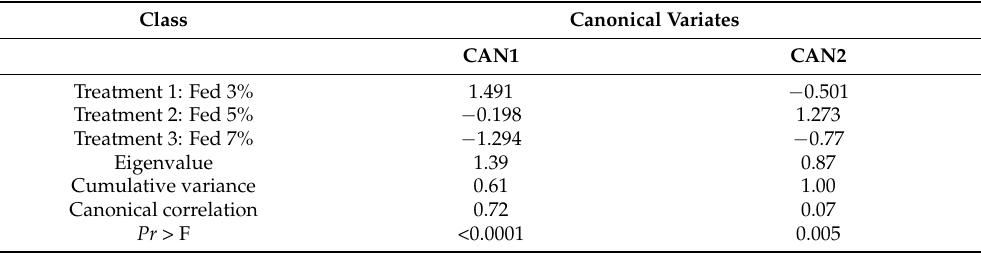
Table 3. Class means on the first two canonical variates based on the fatty acid composition of the northern Largemouth bass whole-body samples of each class (Trial 1).